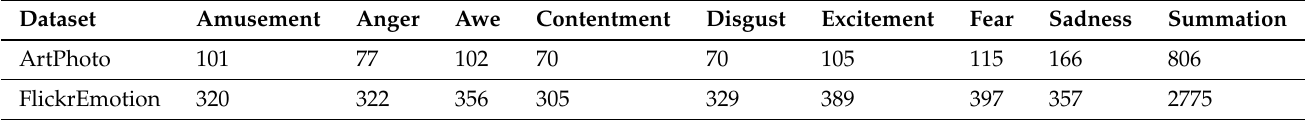
Table 2. Specific classification of different datasets. ArtPhoto and FlickrEmotion have eight categories, namely: amusement, anger, awe, contentment, disgust, excitement, fear, and sadness. The number of images in each category of each dataset is